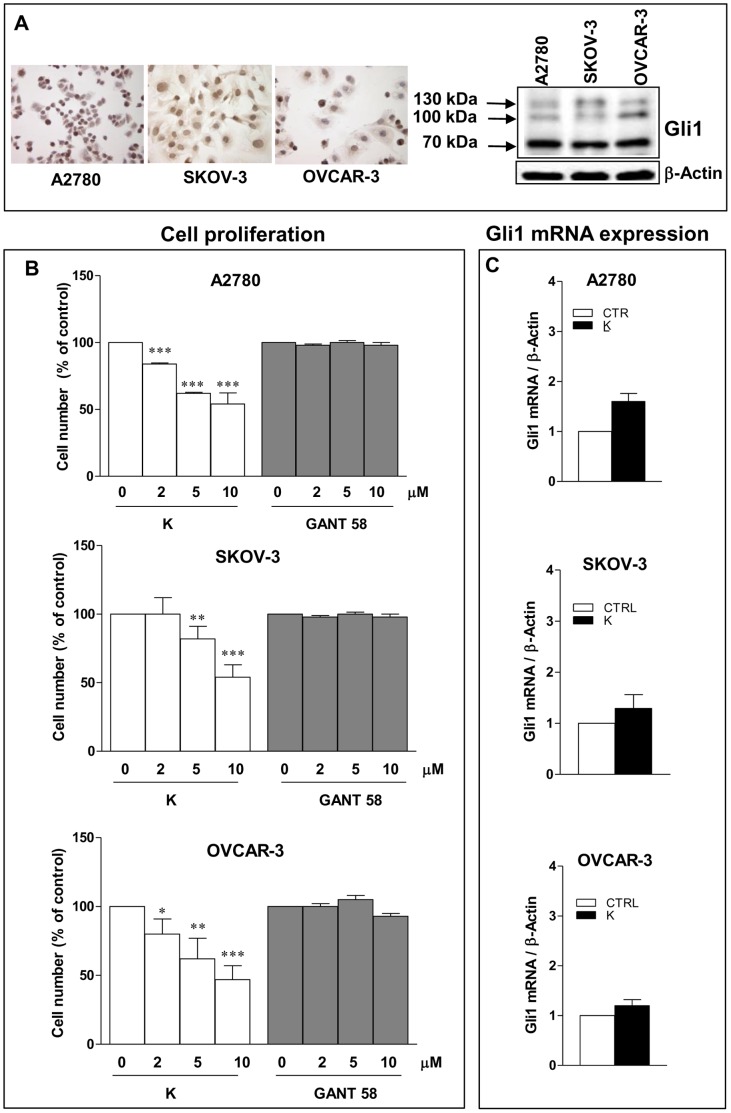
Effect of KAAD-cyclopamine and GANT58 on Hh pathway in human ovarian carcinoma cells.(A) Three human ovarian carcinoma cell lines, A2780, SKOV-3, and OVCAR-3 were subjected to immunostaining with antibody against Gli1. All of three cell lines express Gli1. Protein expression was also confirmed by western blot analysis. β-Actin was used as a loading control. (B) Cells were cultured in 2% FBS medium and treated with 2, 5 and 10 µM KAAD-cyclopamine (K) or GANT58 for 48 h. KAAD-cyclopamine treatment inhibits cell proliferation in all of three cell lines whereas GANT58 does not affect cell growth. Shown are cell number expressed as percentage of DMSO-treated cells (mean ± SD from three different experiments; *P<0.05, **P<0.01, ***P<0.001, t test). (C) Gli1 mRNA expression was evaluated by Q-PCR analysis in ovarian cancer cells treated with 10 µM KAAD-cyclopamine for 48 h. Data are expressed as fold change vs. each respective Control (CTRL), taken as calibrator for comparative quantitation analysis of mRNA levels. Each sample was measured in triplicate, the experiment was repeated 2 times with similar results. Graphics show mean ± SD.